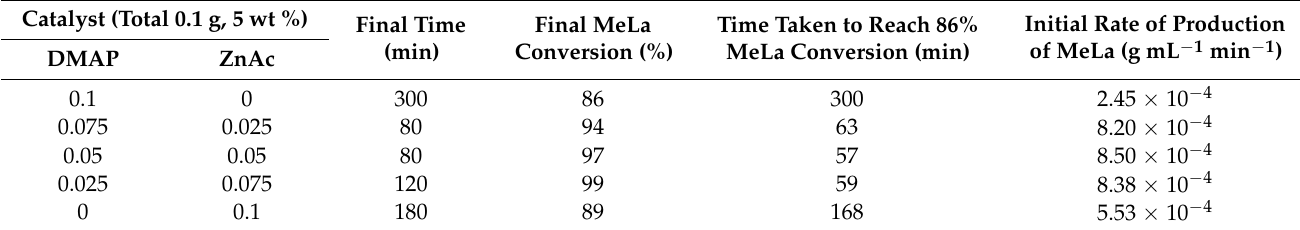
Table 1. Methanolysis of PLA at 130 ◦ C and 300 rpm, effect of different amounts of catalyst on final time (min), final MeLa conversion (%), time taken to reach 86% MeLa conversion, and initial rate of production of MeLa (g mL − 1 min − 1 ). Catalyst (Total 0.1 g, 5 wt %)